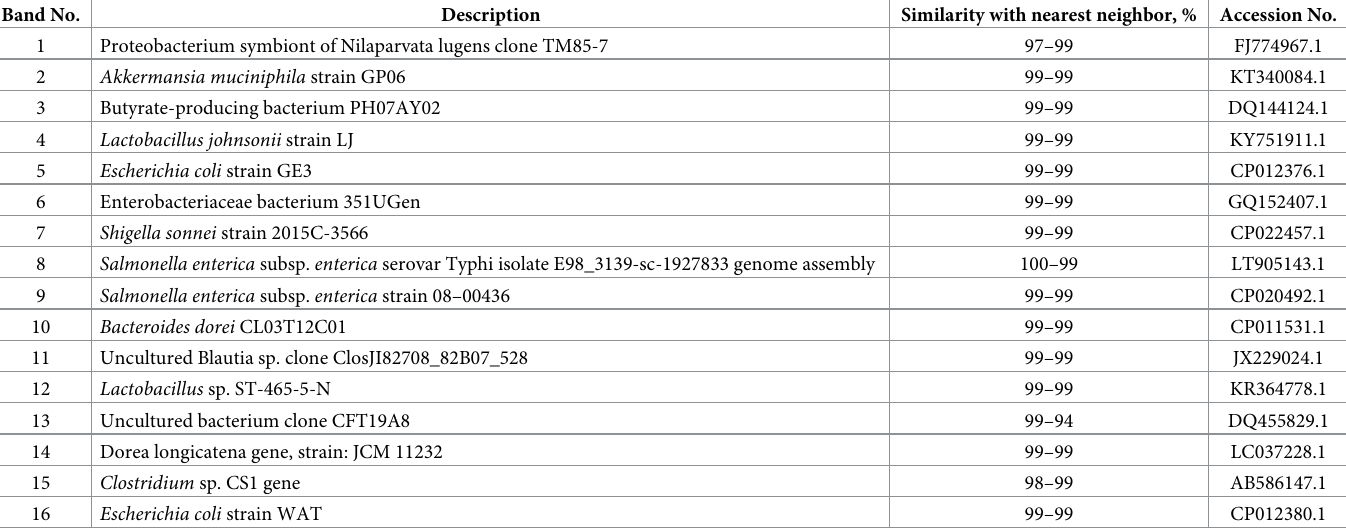
Table 3. Bacterial species identified using DNA sequencing of the PCR-DGGE bands. Band No. Description Similarity with nearest neighbor, % Accession